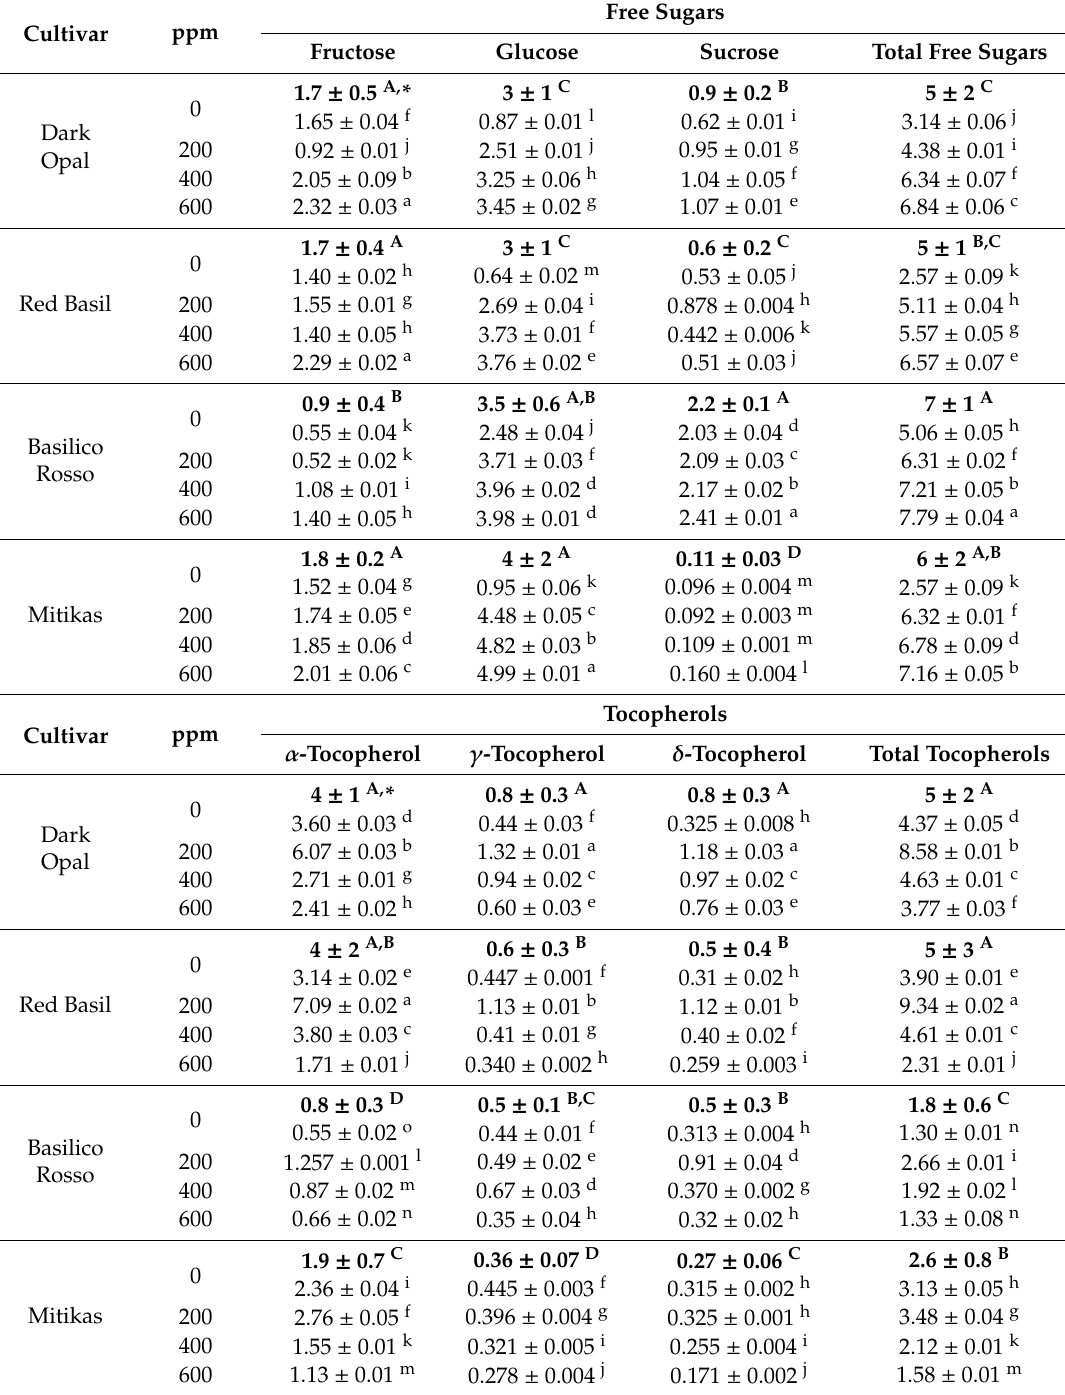
Table 2. Composition in free sugars (g / 100 g dw) and tocopherols (mg / 100 g dw) of the studied basil genotypes in relation to nitrogen input (mean ± SD, n =